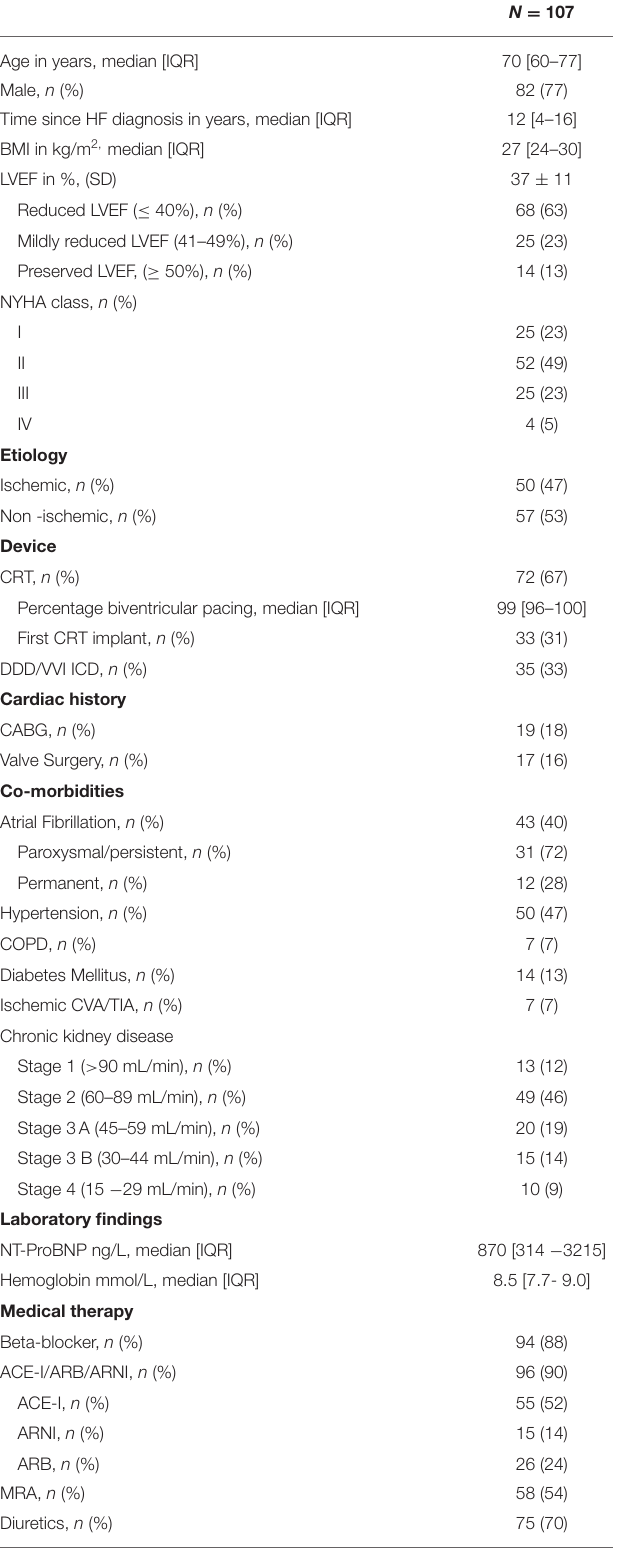
TABLE 1 | Baseline characteristics of the patients included for analysis ( N = 107).